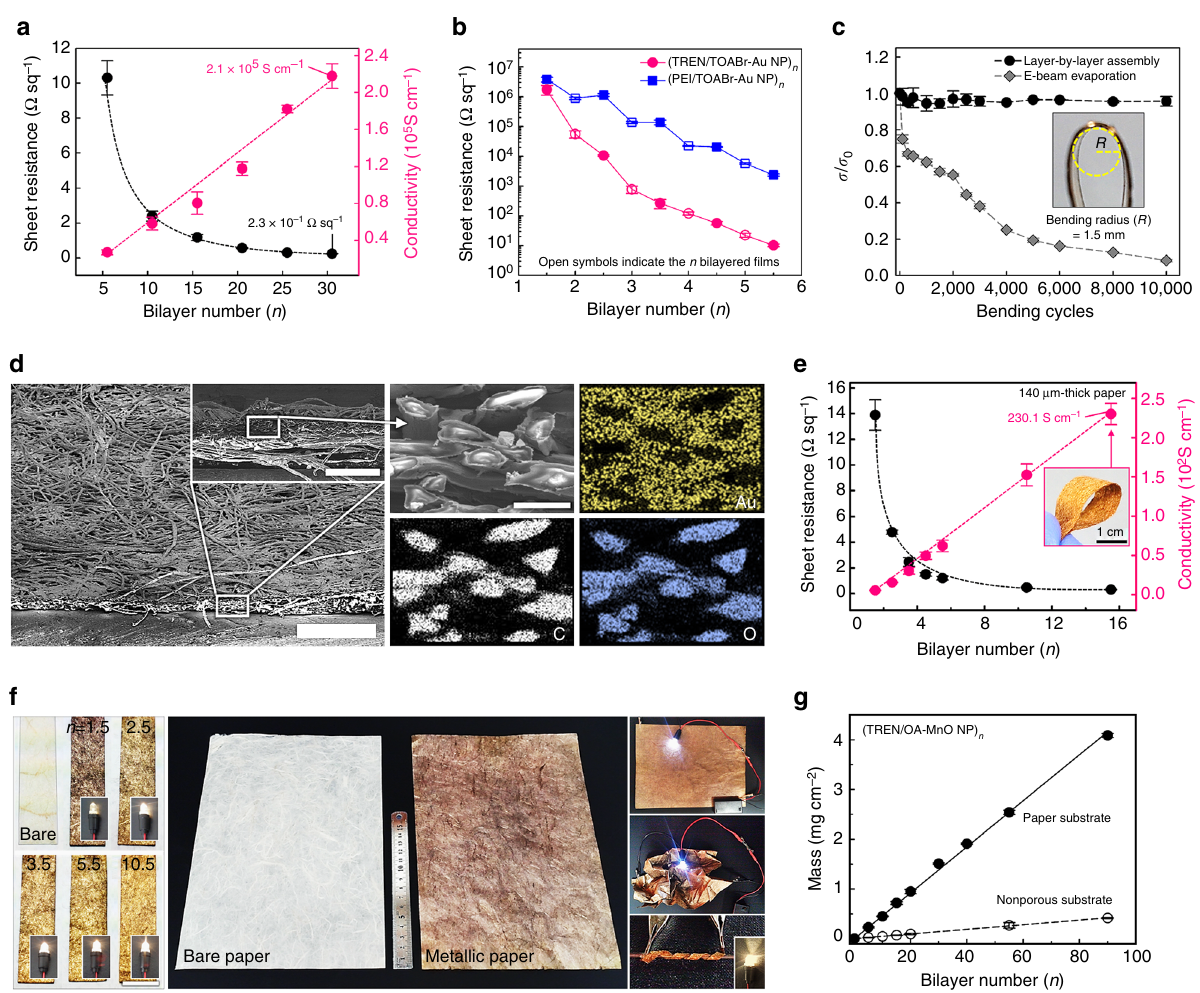
100 )Metallic paperBare Bilayer number ( n Fig. 2 Physical properties of the (TREN/TOABr-Au NP) n -coated electrode. a Sheet resistances and electric conductivities of the (TREN/TOABr-Au NP) n multilayers coated onto quartz glass as a function of the bilayer number ( n ). b Effect of the outermost organic ligands on the sheet resistances of the (TREN/TOABr-Au NP) n and (PEI/TOABR-Au NP) n multilayers coated onto quartz glass. c Mechanical stability tests for the (TREN/TOABr-Au NP) 15.5 multilayer- and the evaporated Au-coated PET substrates as a function of the bending cycling number (bending radius of ~1.5 mm). d Tilted and cross-sectional ( inset ) FE-SEM images of the (TREN/TOABr-Au NP) 10 -coated paper ( scale bar , 500 and 200 µ m ( inset )) ( left ) and EDX mapping images of the (TREN/TOABr-Au NP) 10 -coated paper electrode ( white square of the cross-sectional SEM image ( inset )) ( scale bar , 20 µ m) ( right ). e Electrical properties of the (TREN/TOABr-Au NP) n -coated paper with increasing bilayer number ( n ). f Photographic images of the (TREN/TOABr-Au NP) n -coated paper with an LED connection as a function of the bilayer number ( n ) ( scale bar , 1 cm) ( left ) and the large-area (20 cm × 30 cm) cellulose paper ( middle ). The images on the right indicate the LED connection between the MPs under various fl exible conditions, such as fl at, crumpling, and wrapping (using a glass stick with a diameter of 1.5 mm). g Mass loading of the (TREN/OA-MnO NP) n multilayers coated onto the porous paper electrodes with a thickness of 140 μ m and the nonporous Au-coated QCM electrodes. The mass percentage of the MnO NPs within the multilayers measured from thermogravimetric analyses (TGA) was